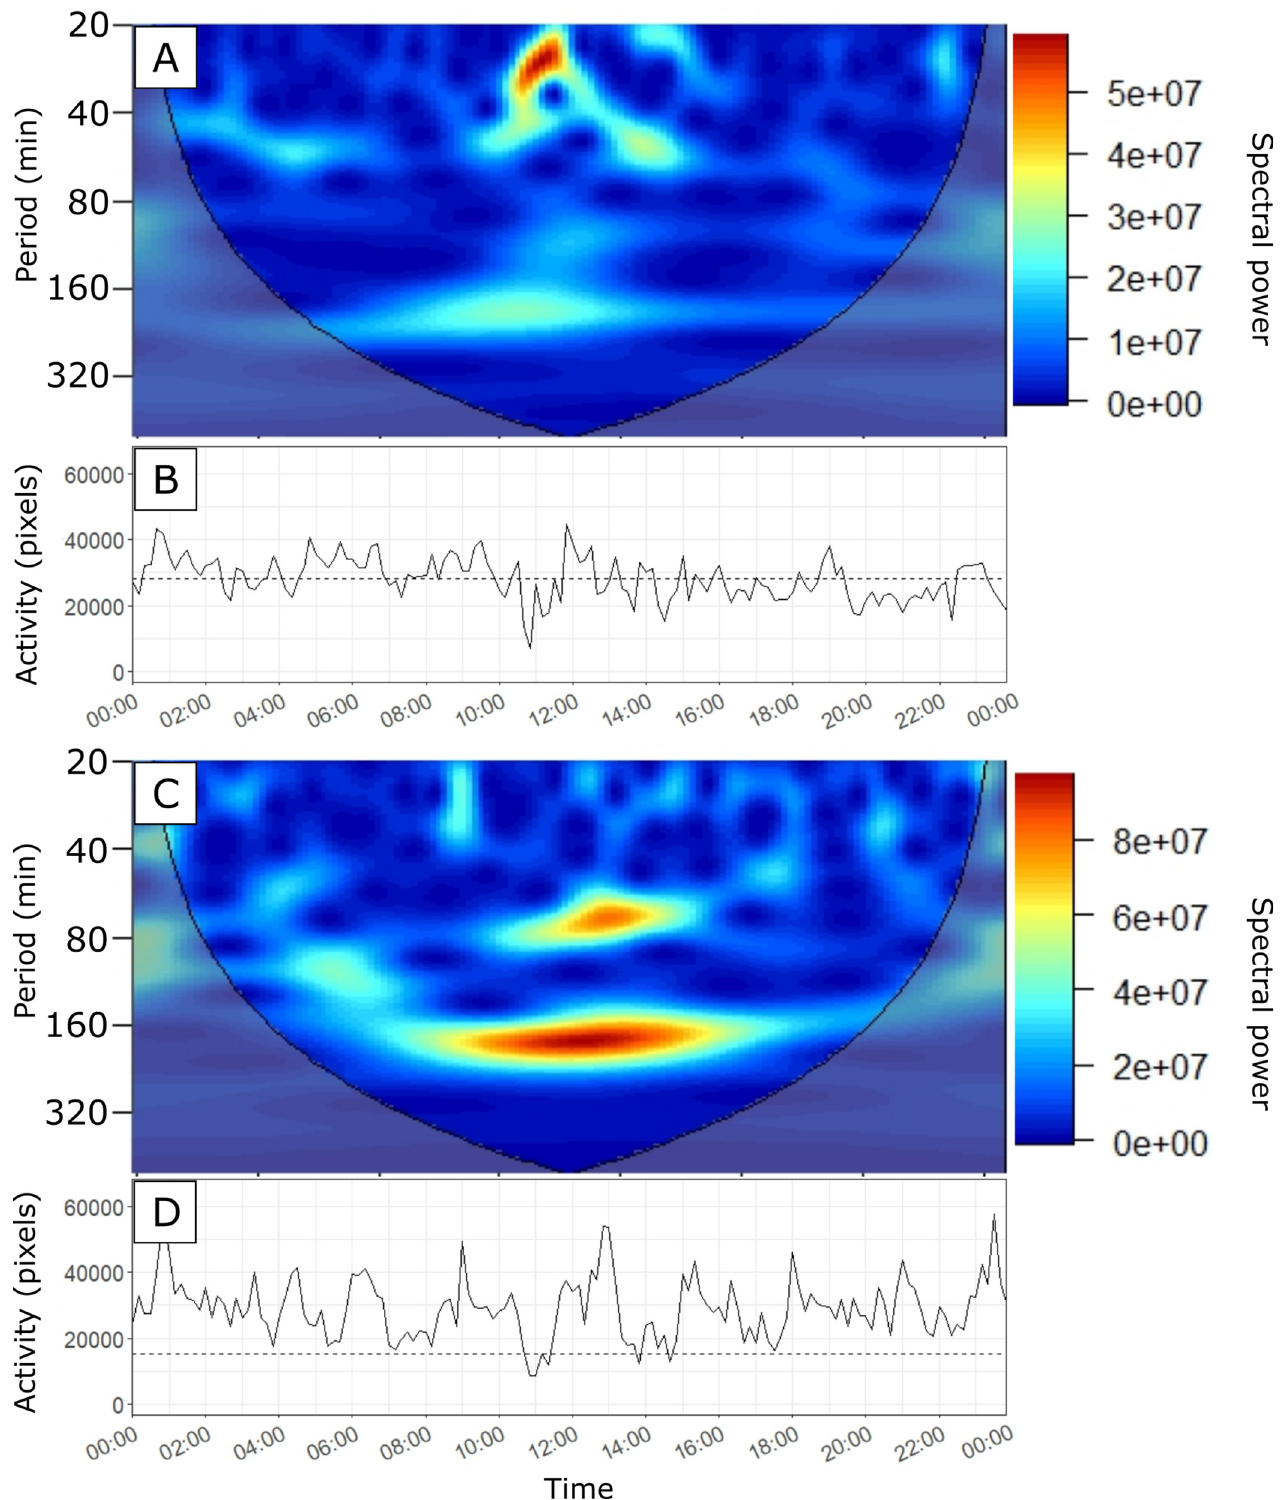
Fig 7. Graph of the CWT with the corresponding activity signal. (A and C) are the CWT with the corresponding activity signal below (B and D). The wavelet analysis displays the spectral power associated with a tested period (left y-axis) at a given time position of the signal (x-axis). The two figures on top (A, B) correspond to day 3 from colony 7 and the two figures at the bottom (C, D) corresponds to day 3 from colony 3. (A) The graph of the CWT showed only a brief